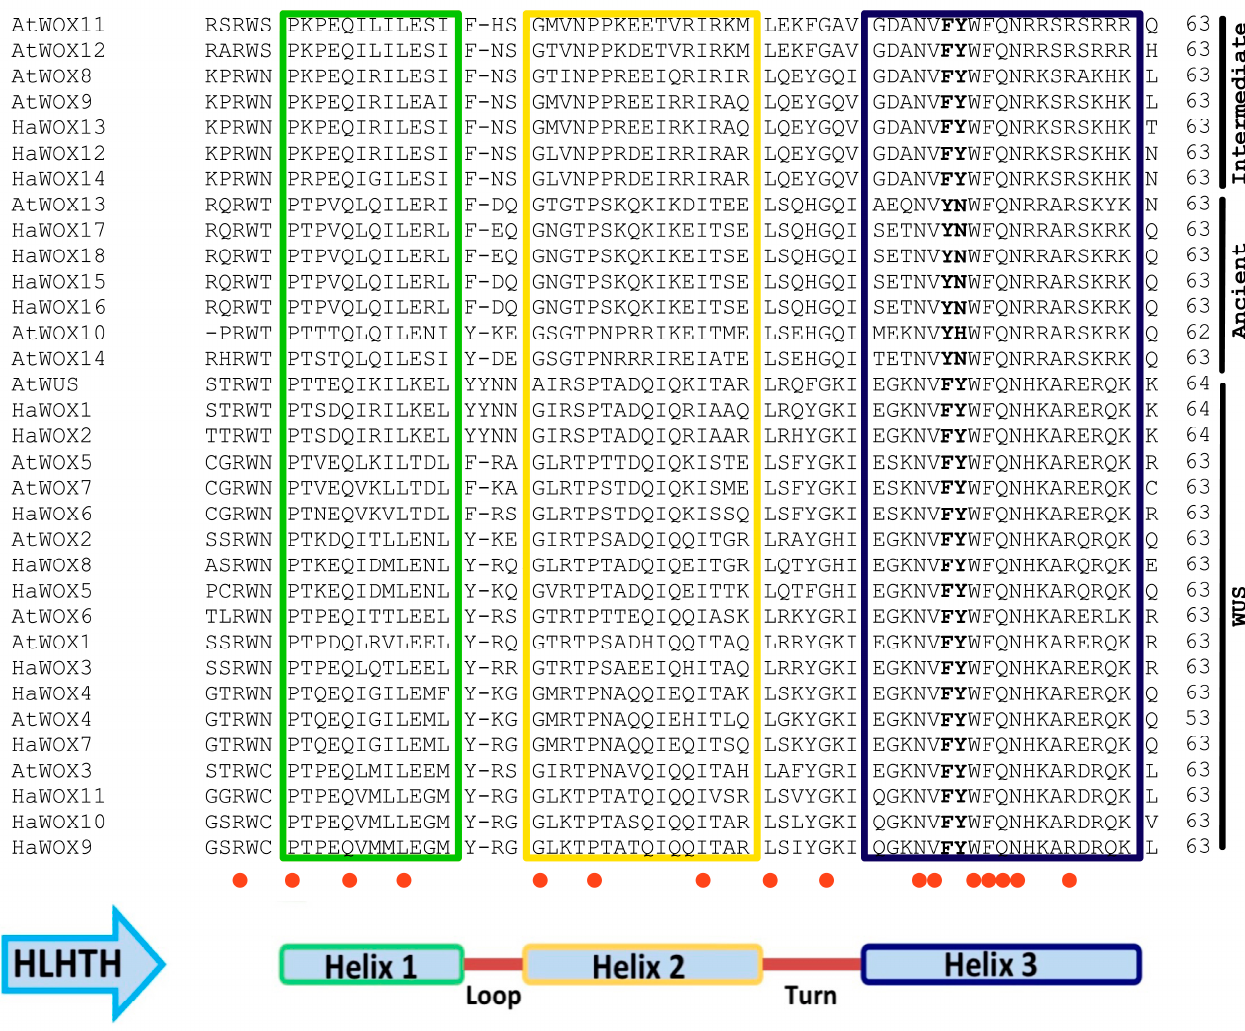
Figure 5. Sequence analysis of homeodomain (HB) in WOX proteins from H. annuus (Ha) and A. thaliana (At). WOX family members showed the typical helix–loop–helix–turn–helix (HLHTH) structure. Red dots evidence completely conserved residues. The amino-acidic di-residues that discriminate the FY WFQ NH , FY WFQ NR , and YN WFQ NR motifs are indicated in bold characters. These motifs are representative markers for the three main clades, WUS, intermediate, and ancient, respectively.